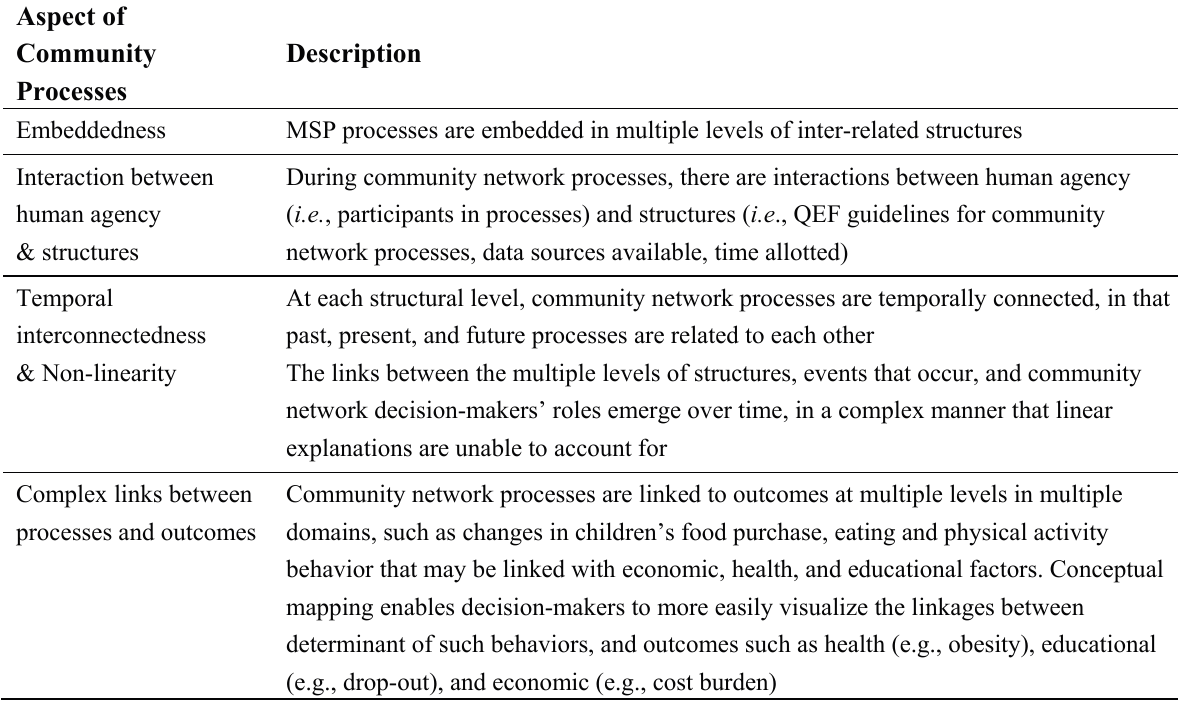
Table 3. Adaptation of framework for our analysis of MSP processes in three communities [19]. Aspect